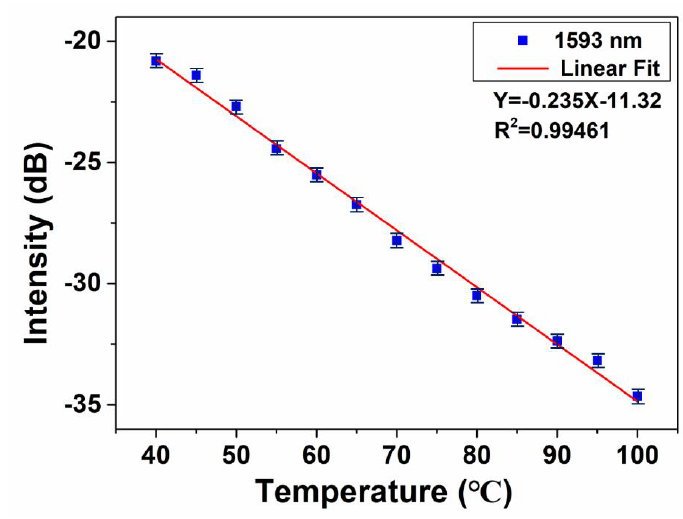
Figure 4. The relationship between temperature and interference intensity at the wavelength of 1593 nm.